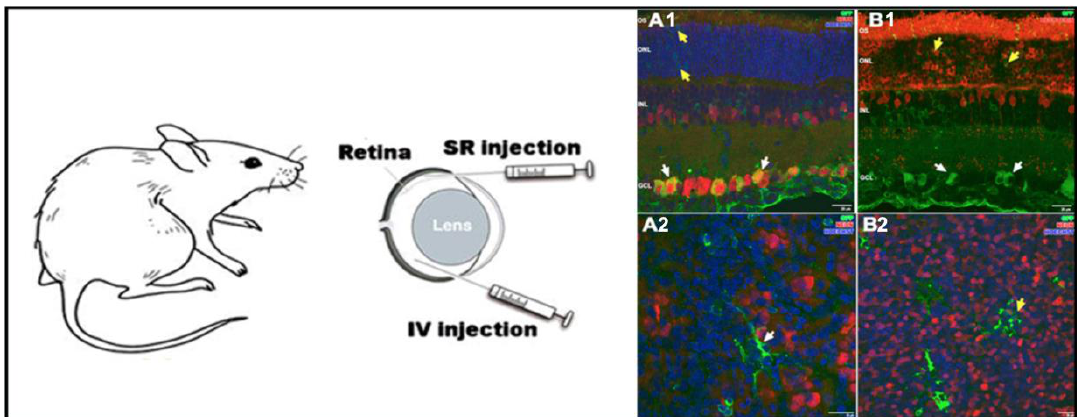
Figure 6. In vivo applications of niosomes in retina. Niosomes transfected di ff erent layers in the rat retina, depending on the administration route. Retinal cross sections micrographs obtained by confocal microscopy ( A1 , B1 ), confocal fluorescence micrographs of whole mount ( A2 , B2 ). Adapted with permission from Mashal et al. [114]. Copyright 2019, Elsevier